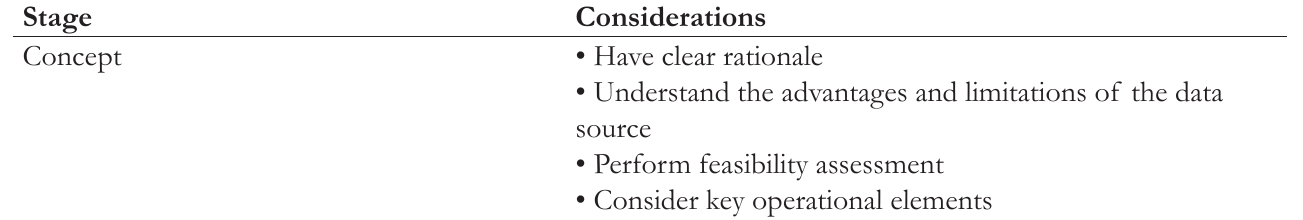
Table 3. Summary of Considerations for Designing Secondary Use of Data